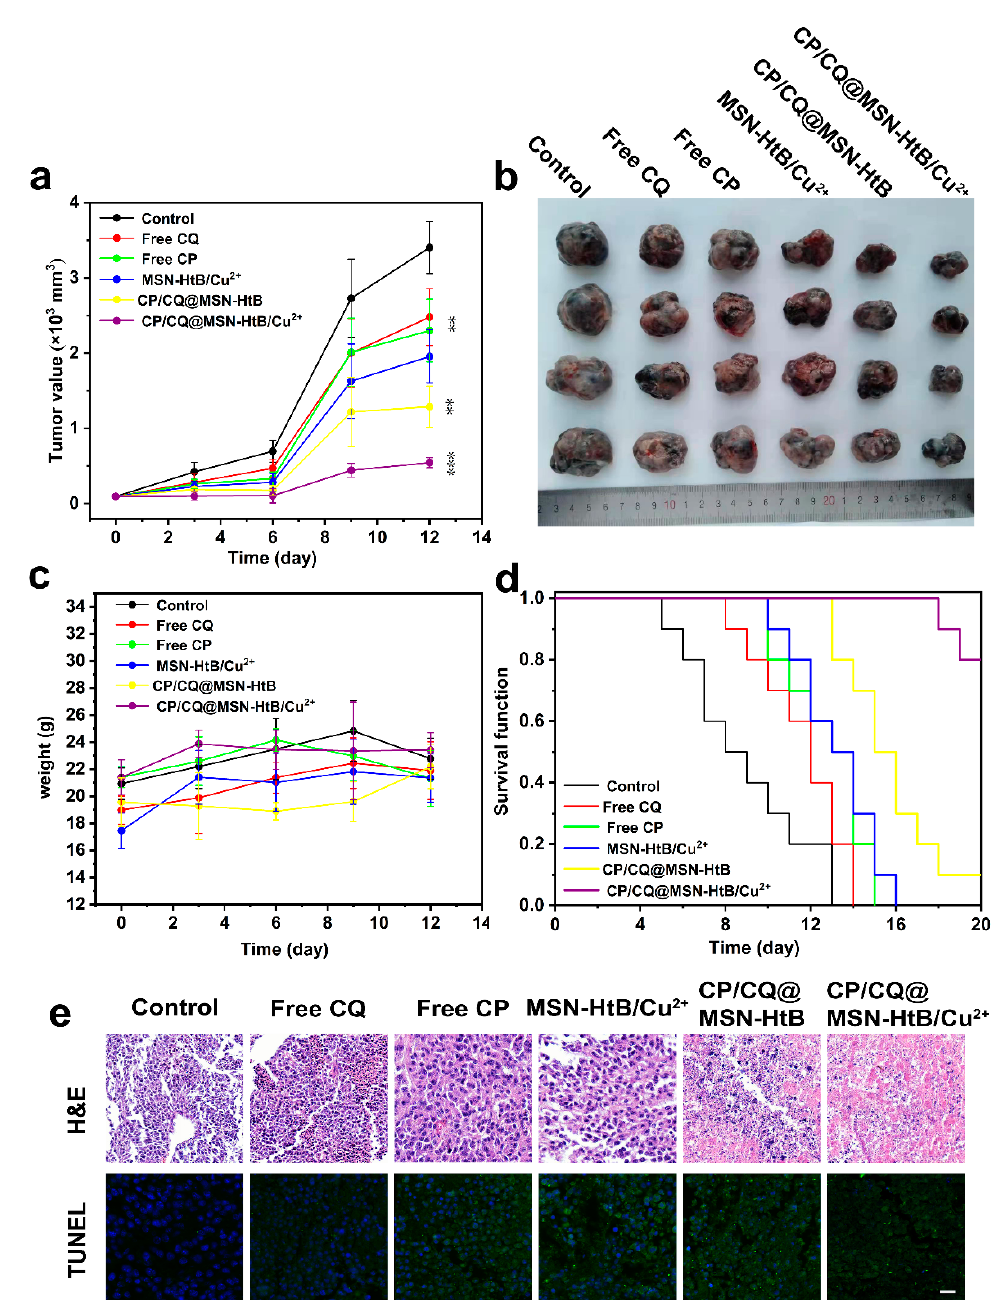
Figure 6. The results of in vivo antitumor studies: ( a ) The tumor volume growth curves (** p < 0.01, *** p < 0.001) and ( b ) representative photographs of tumors isolated on day 12. ( c ) Average body weight changes. ( d ) Kaplan–Meier survival curves. ( e ) H&E staining and TUNEL staining of tumor sections. Scale bars: 20 μ m.